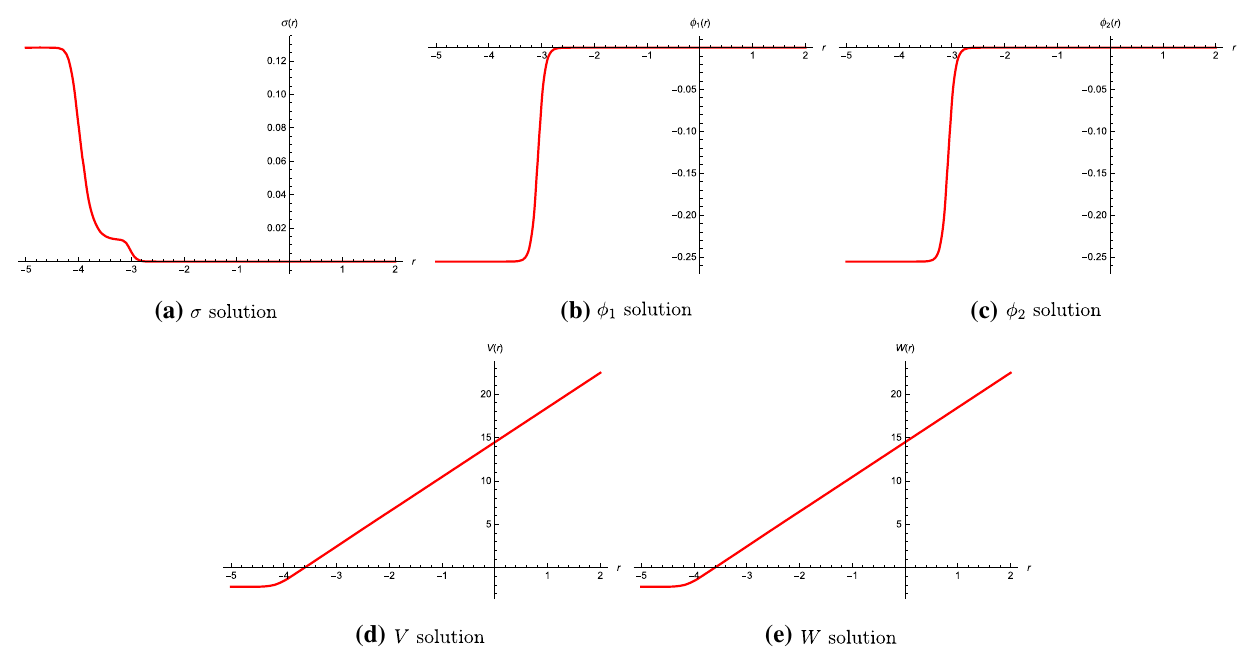
Fig. 8 An RG flow from SO ( 4 ) N = ( 1 , 0 ) SCFT to SO ( 3 ) N = ( 1 , 0 ) SCFT in six dimensions and then to two-dimensional N = ( 2 , 0 ) SCFT with SO ( 2 ) diag symmetry dual to AdS 3 × H 2 × H 2 solution